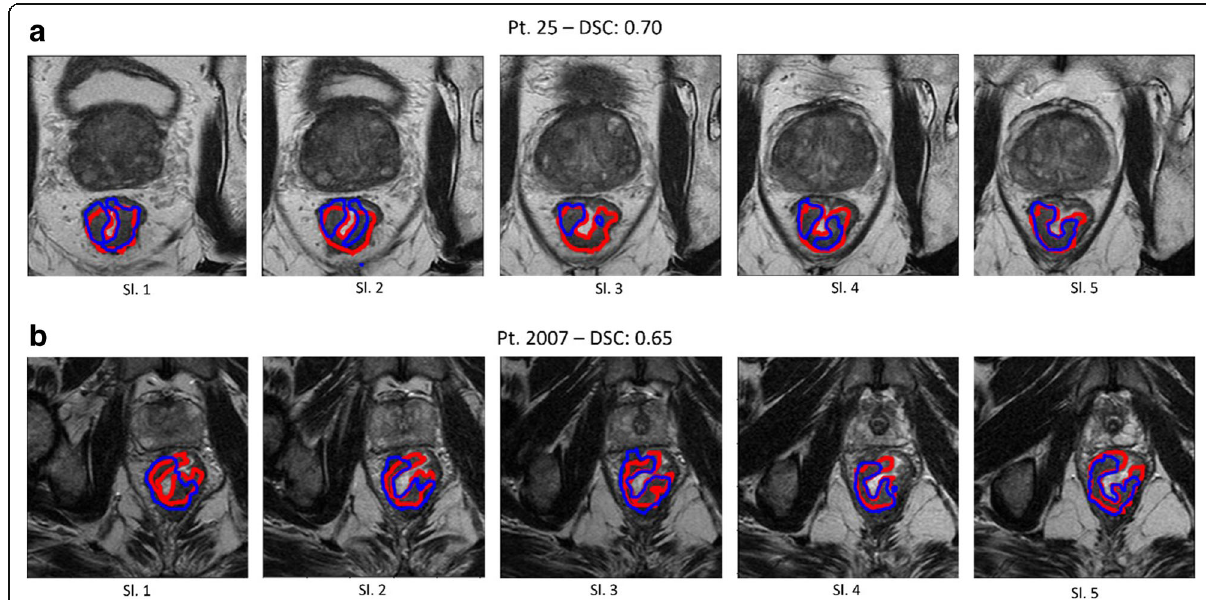
Fig. 1 Examples of automatic segmentations of rectal cancer using the fully convolutional network model (blue line) and manual segmentation (red line) in different slices of two patients. First row: patient no. 25 with a DSC of 0.70; second row: patient no. 2007 with a DSC of 0.65. DSC Dice similarity coefficient, Pt Patient, Sl.